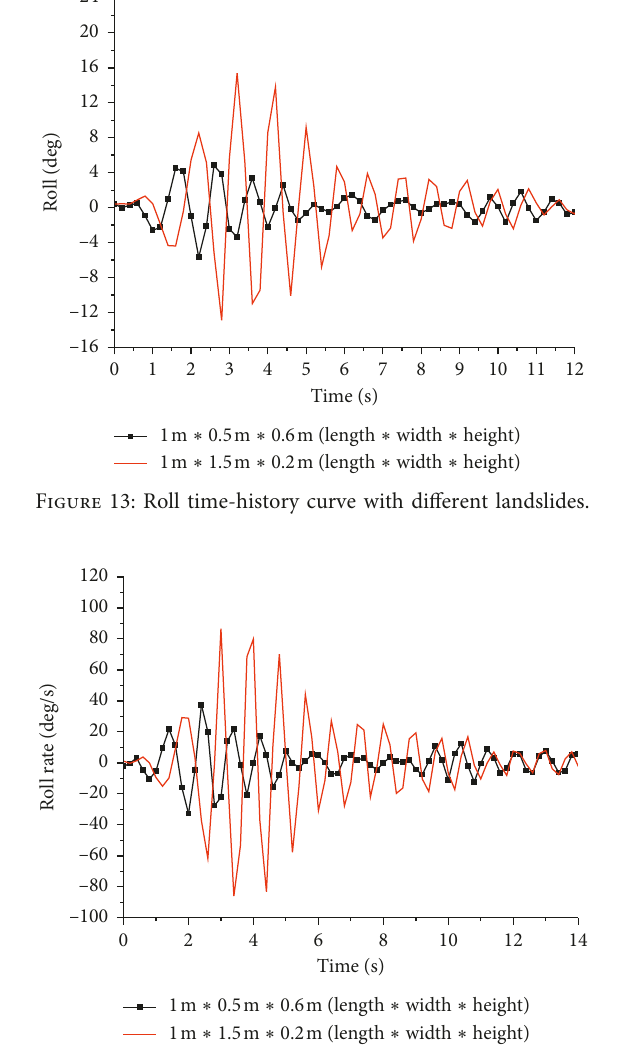
Figure 14: Ship’s roll angular velocity time-history curve for different